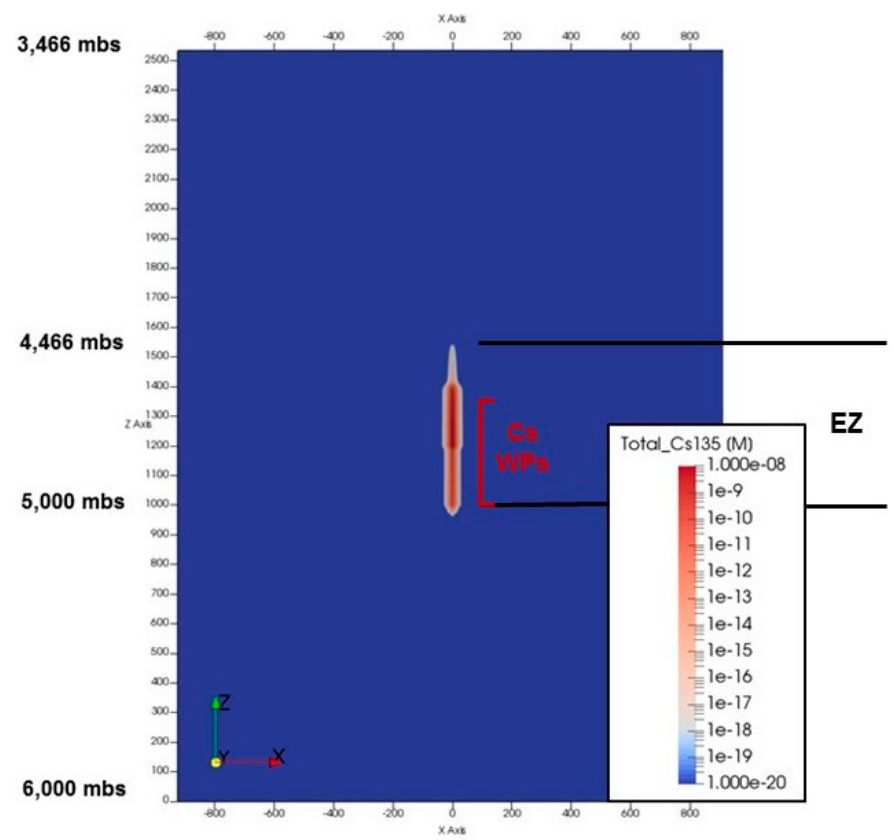
Figure 6. Dissolved concentration of 135 Cs at 10,000,000 years for the nominal scenario. Source: Freeze et al. [5].